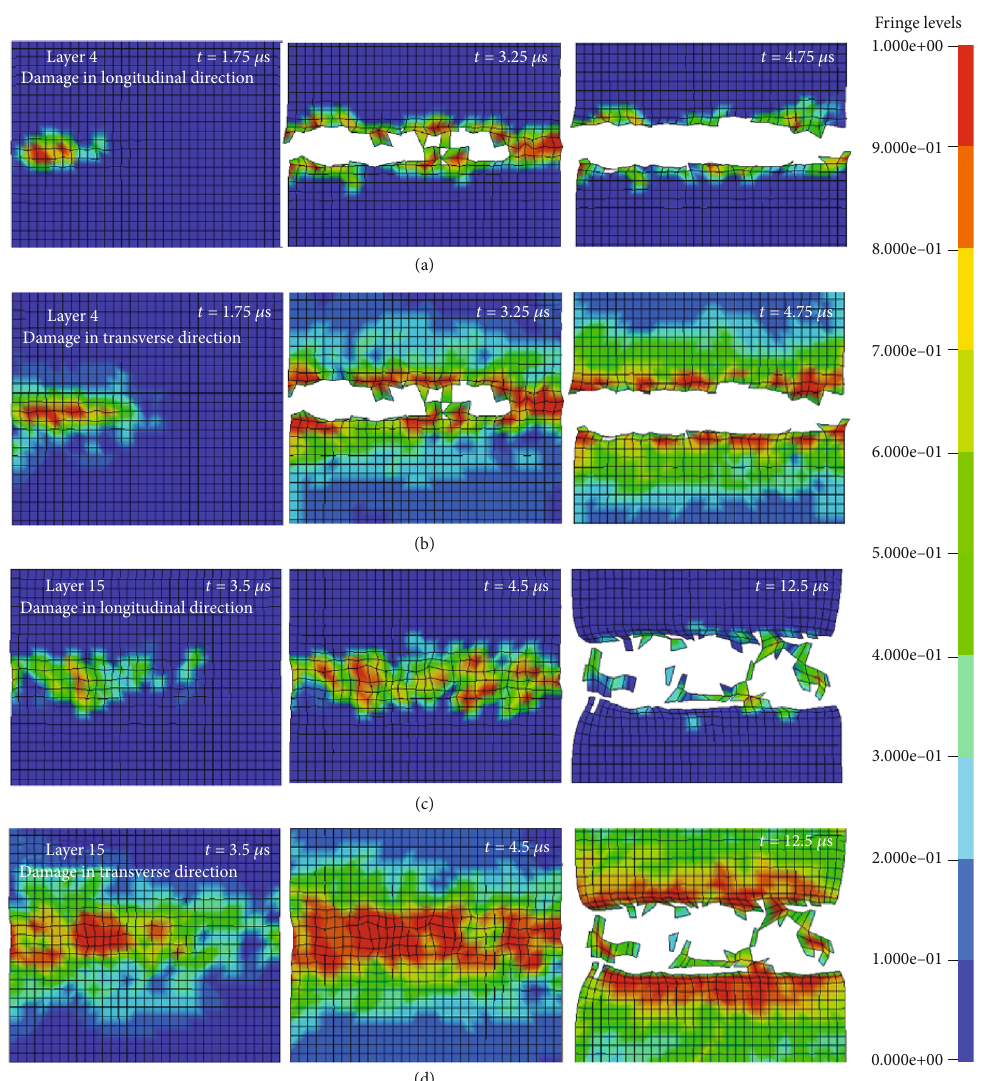
Figure 13: Comparison of in-plane failure in the sublayers (a, c). Damage in longitudinal direction for layer 4 and layer 15 (b, d). Damage in transverse direction for layer 4 and layer